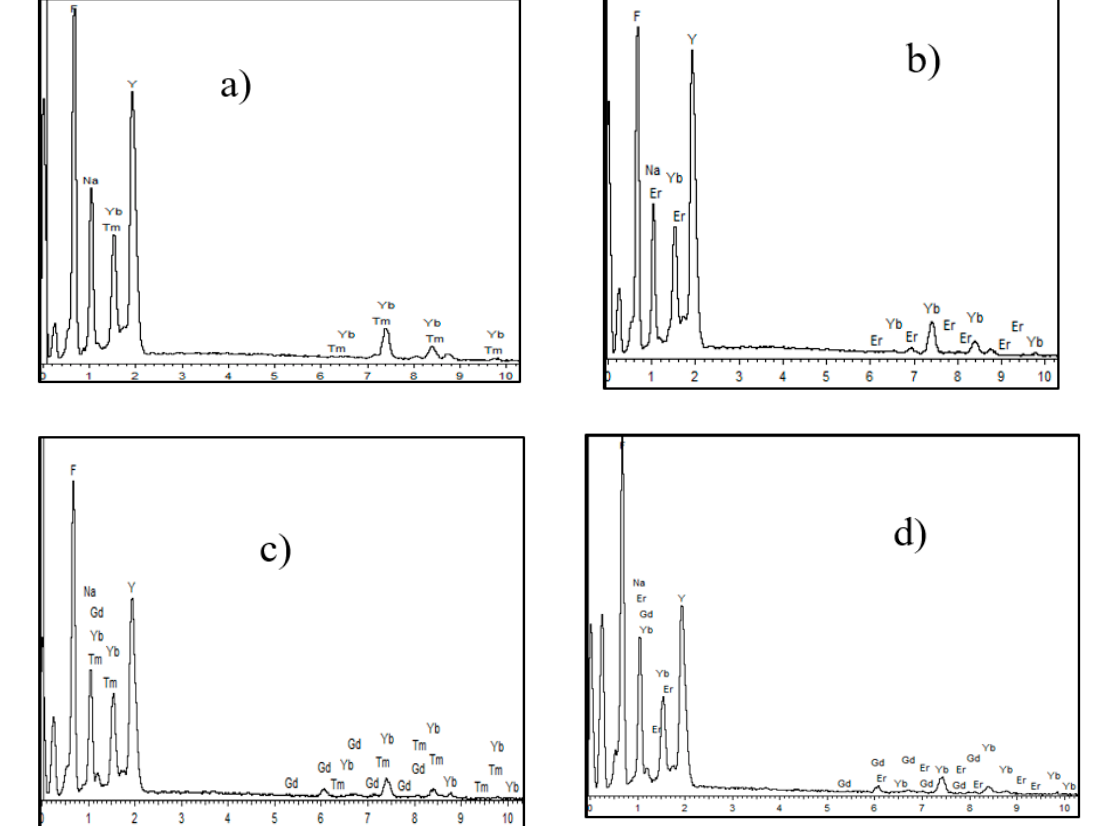
Figure 4. EDX spectra of the samples: ( a ) β -NaYF 4 : 20%Yb, 1% Tm, ( b ) β -NaYF 4 : 20%Yb, 1% Er, ( c ) β -NaYF 4 : 20%Yb, 1% Tm, 5% Gd, and ( d ) β -NaYF 4 : 20%Yb, 1% Er, 5% Gd.